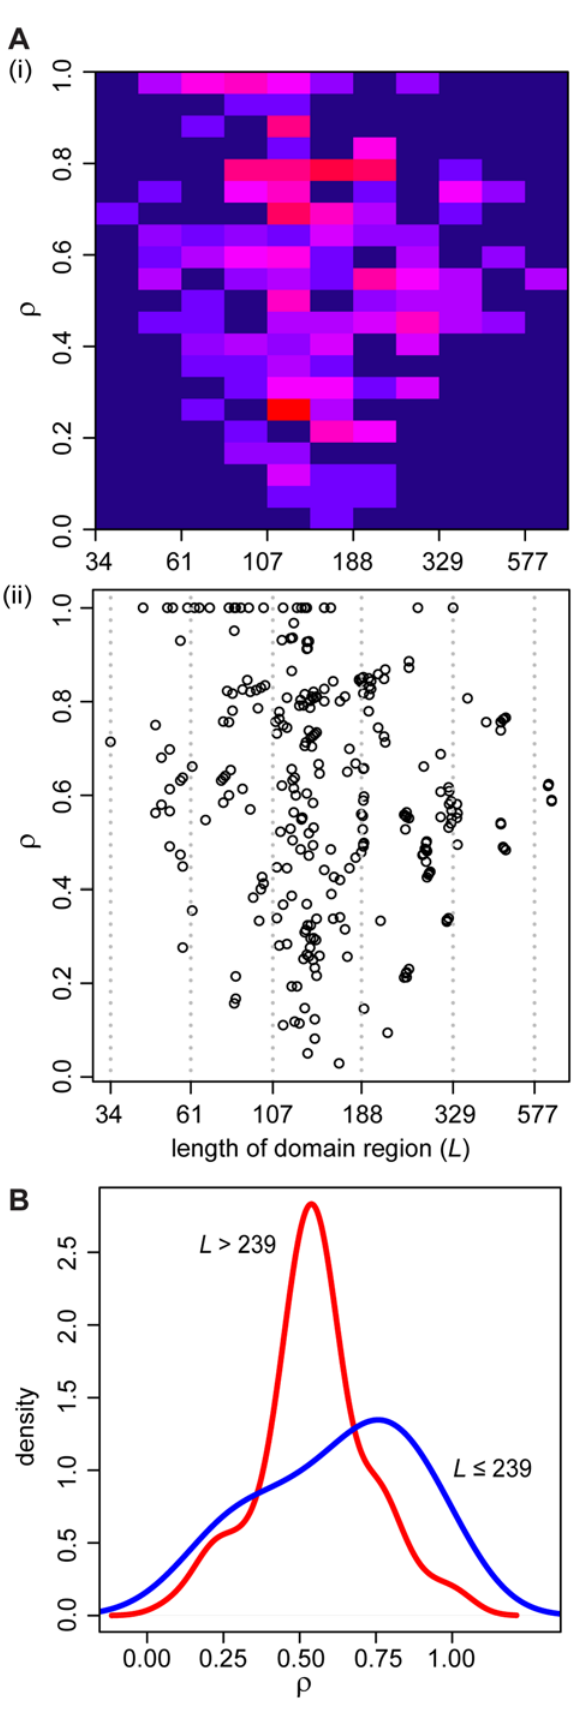
Figure 2. Relationship between r and domain lengths. (A) Relationship between r and the length of the corresponding domain region for each inferred breakpoints in the dataset shown as (i) a heat map and (ii) a dot plot ( n =311, including r =1). The color in each cell in the heat map ranges from dark blue (the fewest data points, minimum 0) to bright red (the most data points, maximum 13). The column of domain lengths 105–142 contains the most data points, 92. Domain lengths in the X-axis for both (i) and (ii) are shown in natural logarithmic scale. (B) Density plot of r for instances in which the corresponding domain length, L # 239 (blue line, n =242) and instances in which L . 239 (red line, n =69). The r distances in cases in which L # 239 are significantly greater than those where L .